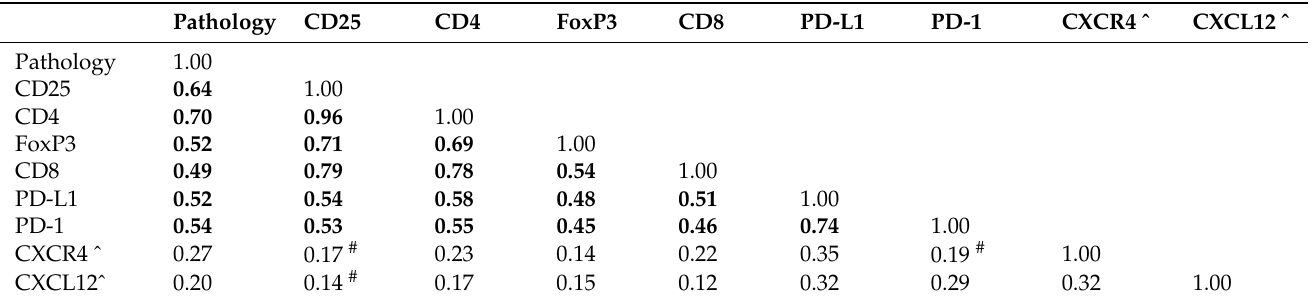
IHC vs. pathology (scored on an ordinal scale) associations are presented as Spearman correlation coefficients whereas correlations between markers are presented as Pearson correlation coefficients. bold, p < 0.01; # , p < 0.05; and ˆ published IHC data re-analyzed in the context of new data presented here